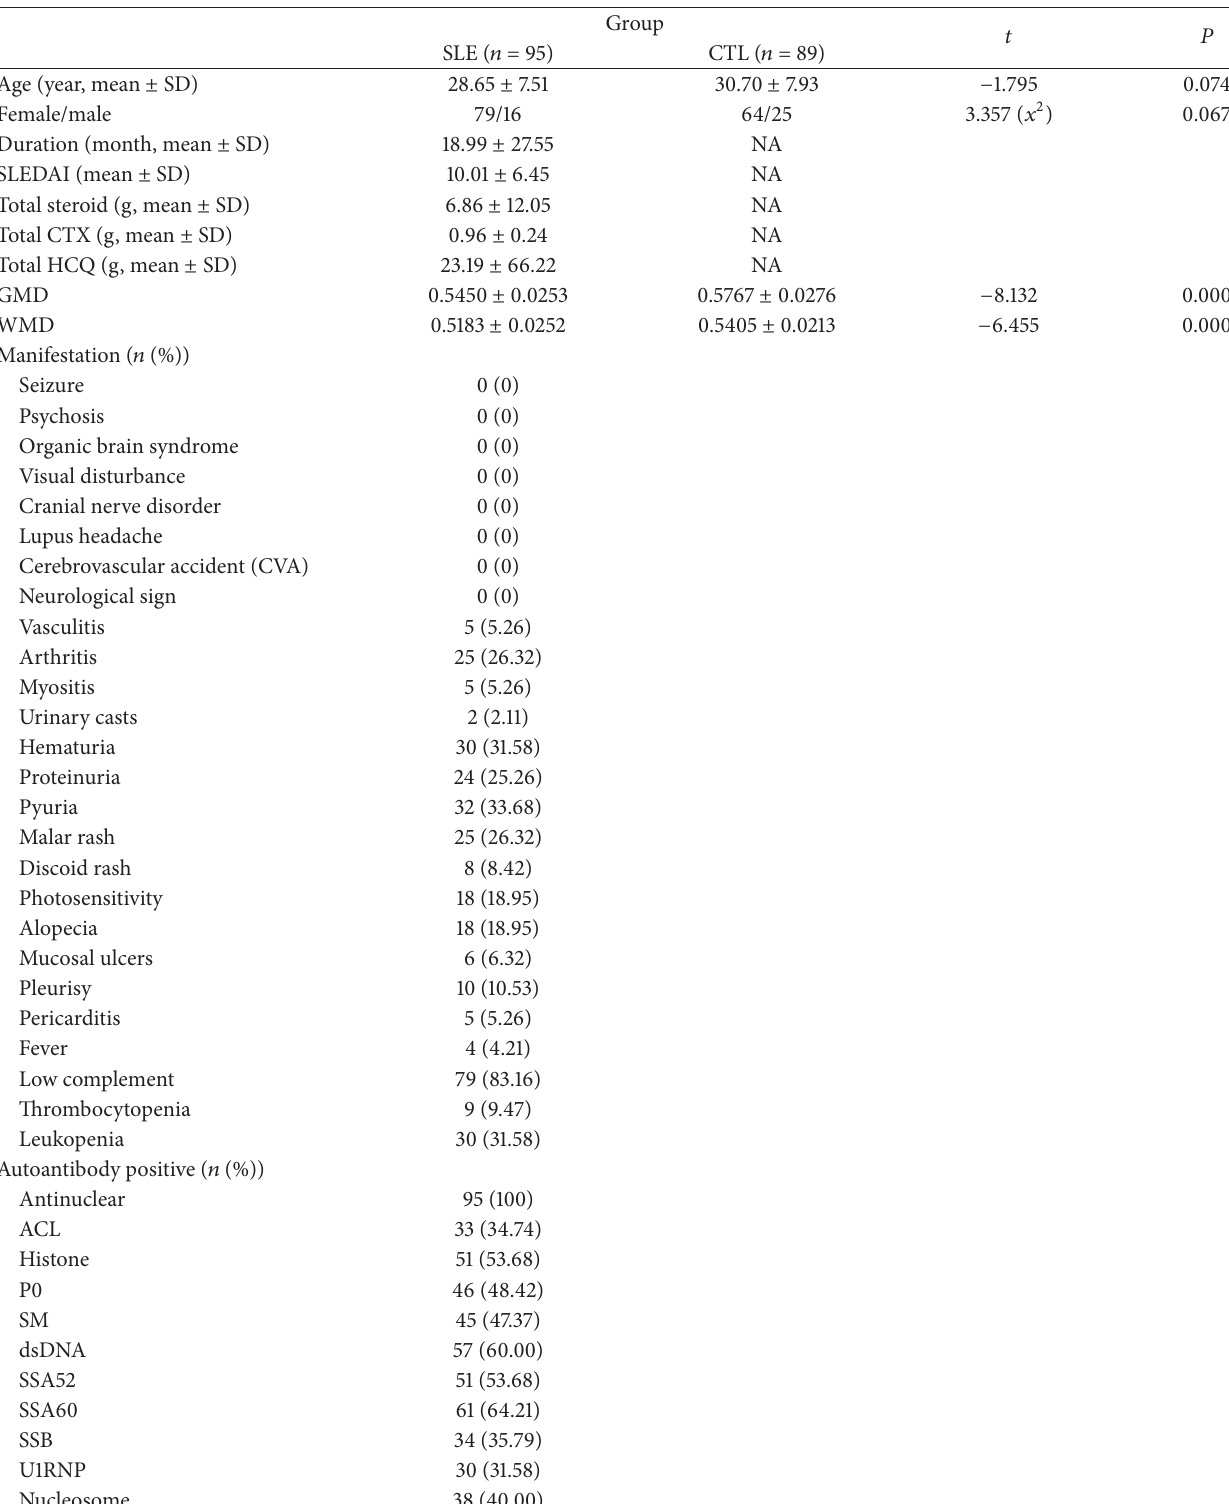
Table 1: Demographic and clinical characteristics of SLE patients and healthy